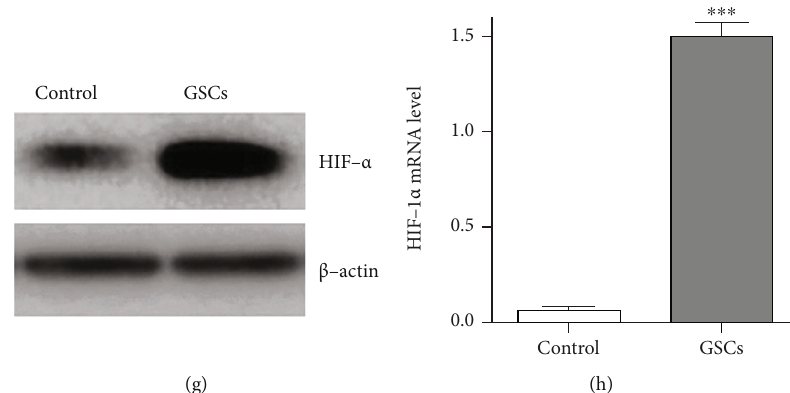
Figure 1: HIF-1 α and 14-3-3 β expression in GSCs. (a) 14-3-3 β protein expression in GSC cells. (b) 14-3-3 β mRNA level in GSC cells (vs. control, P < 0 : 001 ). (c) E ff ect of 14-3-3 β siRNA transfection on the 14-3-3 β expression in GSC cells. (d) E ff ect of 14-3-3 β siRNA transfection on 14-3-3 β mRNA level in GSCs cells ( 14-3-3 β siRNA vs. control, P < 0 : 001 ). (e) E ff ect of hypoxia induced by using CoCl on the 14-3-3 β protein expression in GSC cells. (f) E ff ect of hypoxia on 14-3-3 β mRNA level in GSC cells (CoCl 0 : 001 ; CoCl 150 μ M vs. control, P < 0 : 001 ). (g) HIF-1 α expression in GSC cells. β -Actin was used as a loading control. (h) HIF-1 α 2 mRNA level in GSCs cells (vs. control, P < 0 : 001 ).